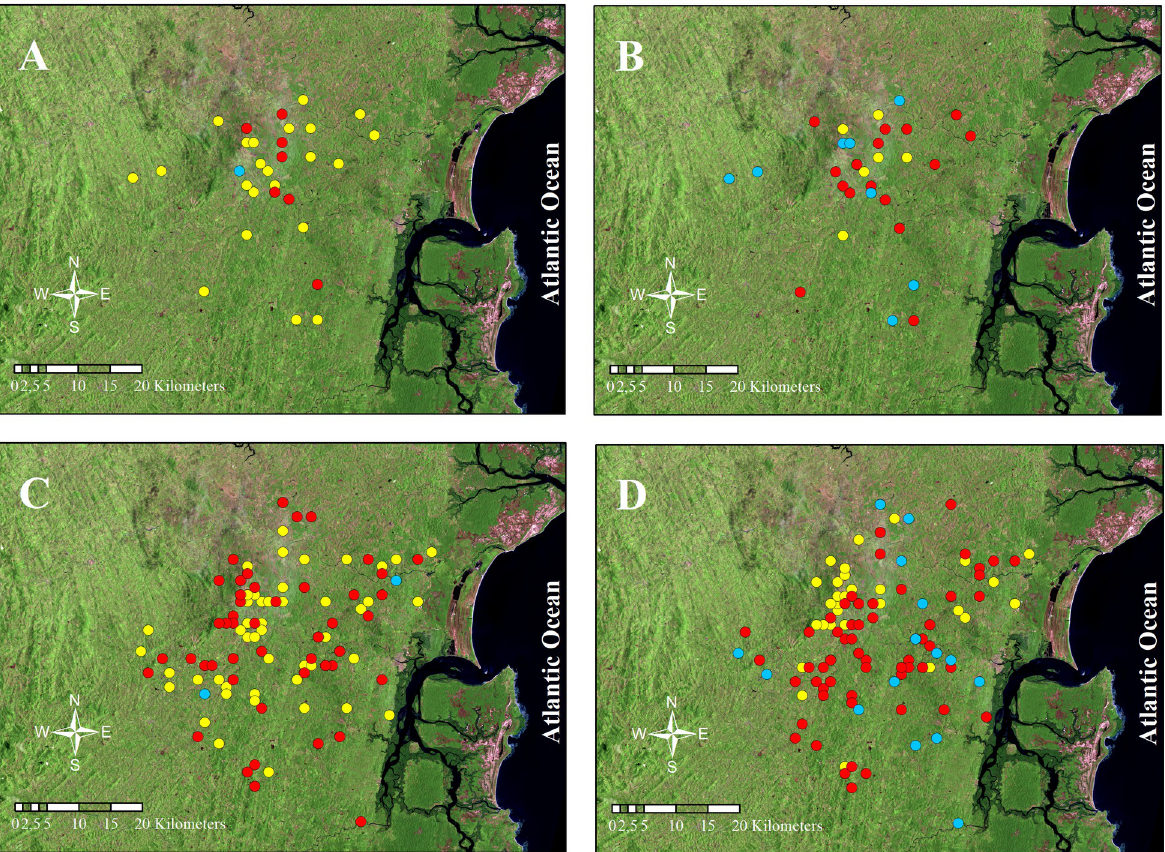
Fig 4. Homozygous and heterozygous genotypes in L . braziliensis loci greatly overlap in Corte de Pedra. Homozygous and heterozygous genotypes observed in L . braziliensis loci CHR24/3074 and CHR28/425451 of parasites obtained during 1999–2001 (A and B) and 2008–2011 (C and D) sampling periods were mapped and the resulting sets of geographic events were statistically compared. CHR24/3074 (A and C): CTTCAG: CTTCAG (yellow), CTTCAG: TCATGA (red) and TCATGA: TCATGA (blue). CHR28/425451 (B and D): CCT:CCT (yellow), CCT:TT- (red) and TT-:TT- (blue). Cuzick and Edward´s comparisons of combined homozygous versus heterozygous spatial distributions rendered non-significant (p > 0.05) for data depicted in all four maps of the panel. Total number of dots plotted in each map may be smaller than the number of corresponding parasite isolates described in text due to overlap of some ATL patients’ geographic coordinates. Link to the United States Geological Survey (USGS) Landsat satellite photograph used in the figure [39]: https://earthexplorer.usgs.gov/scene/metadata/full/5e83d1193824e4fc/